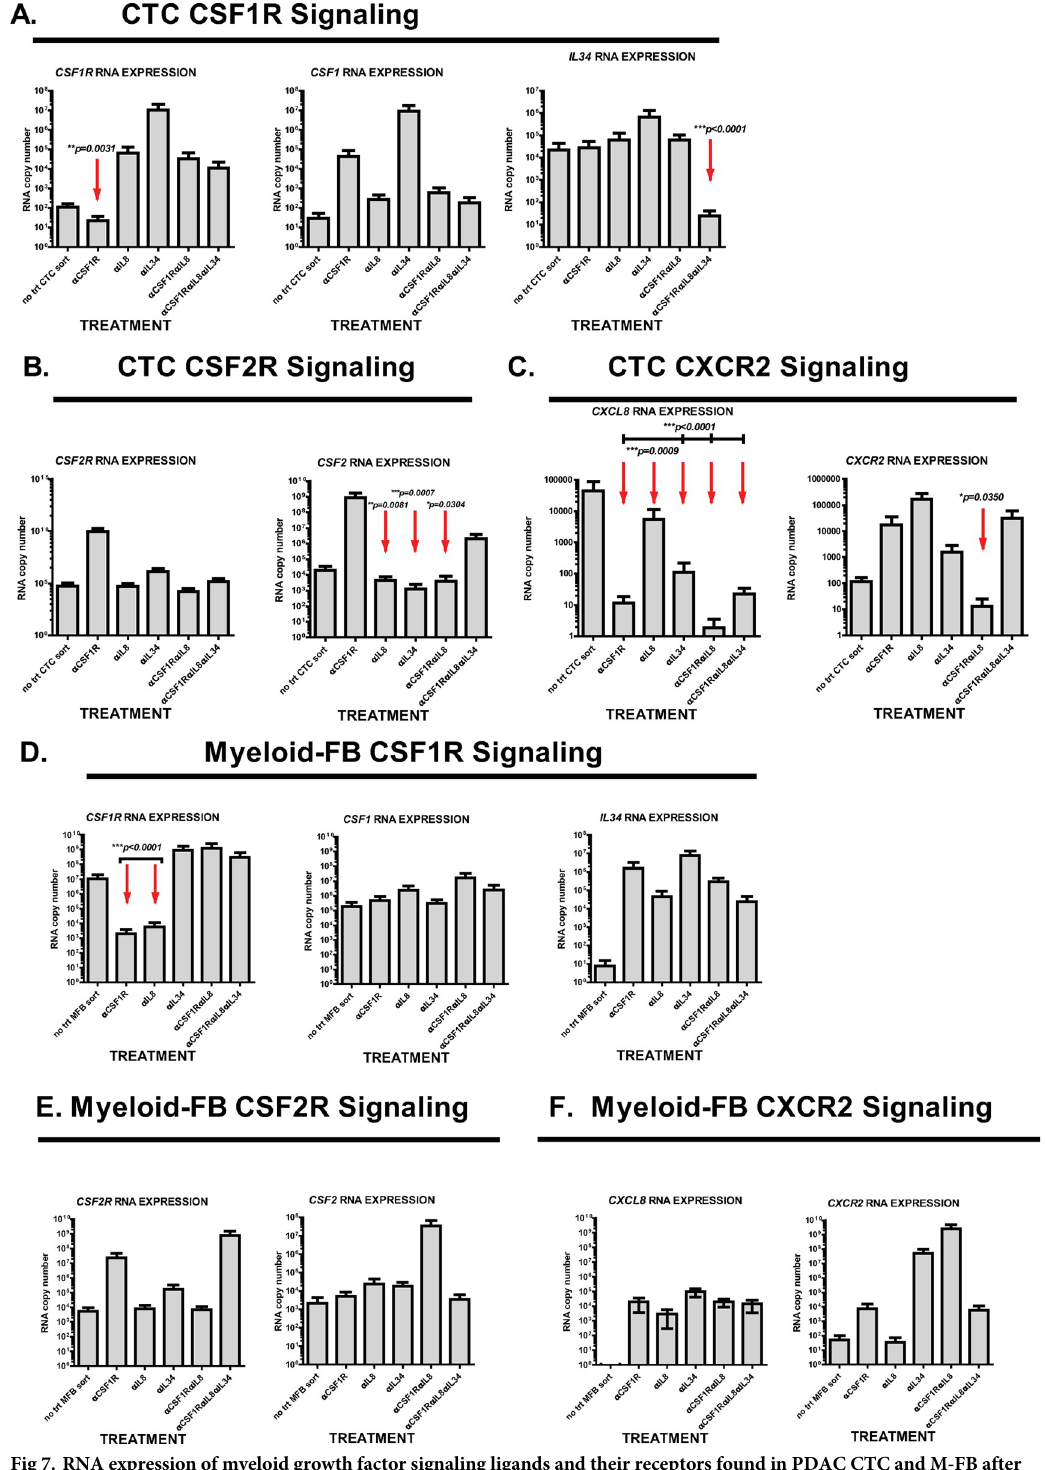
Fig 7. RNA expression of myeloid growth factor signaling ligands and their receptors found in PDAC CTC and M-FB after PortalBMC ex vivo culture. CTC and M-FB from PortalBMC of 6 PDAC patients were FACS isolated after 7 days in culture with or without ( no trt ) treatment with 4mg/kg humanized anti-CSF1R (BMS-986227, Cabiralizumab), 10mg/kg humanized anti-IL-8 (BMS-986253), 4mg/kg anti-IL-34 (Abcam). Isolated CTC and M-FB were extracted and analyzed for CSF2 , CSF1 , IL34 , IL8 , CXCR2 , CSF1R , and CSF2R by Real Time RT-PCR for RNA expression related to ( A&D ) CSF1R signaling ( CSF1R , CSF1 , IL34 ),